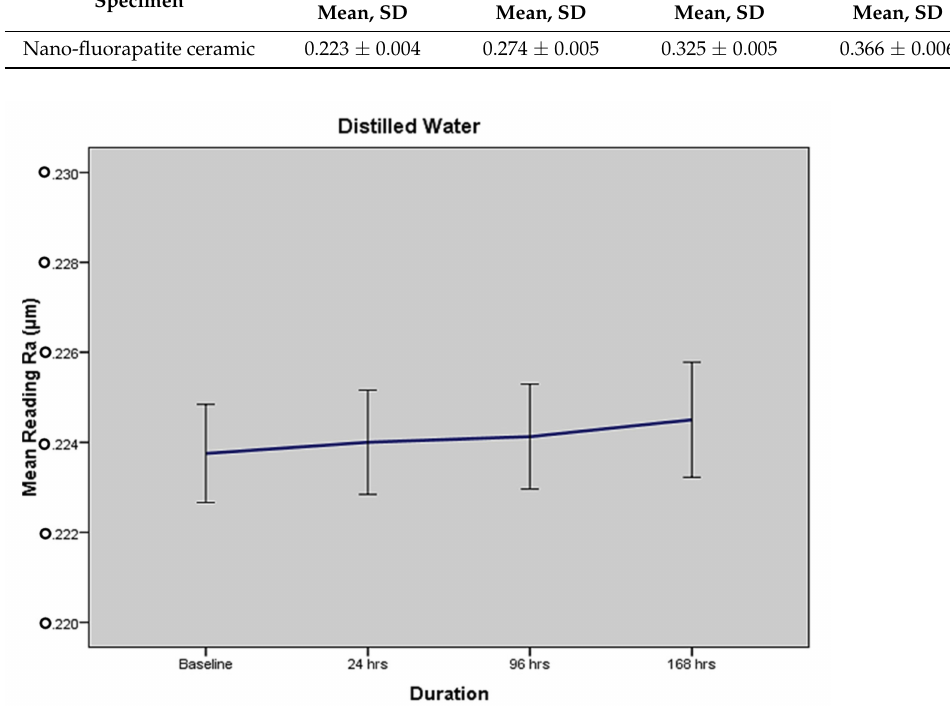
Figure 1. Time related change in surface roughness (mean Ra with standard error) for distilled